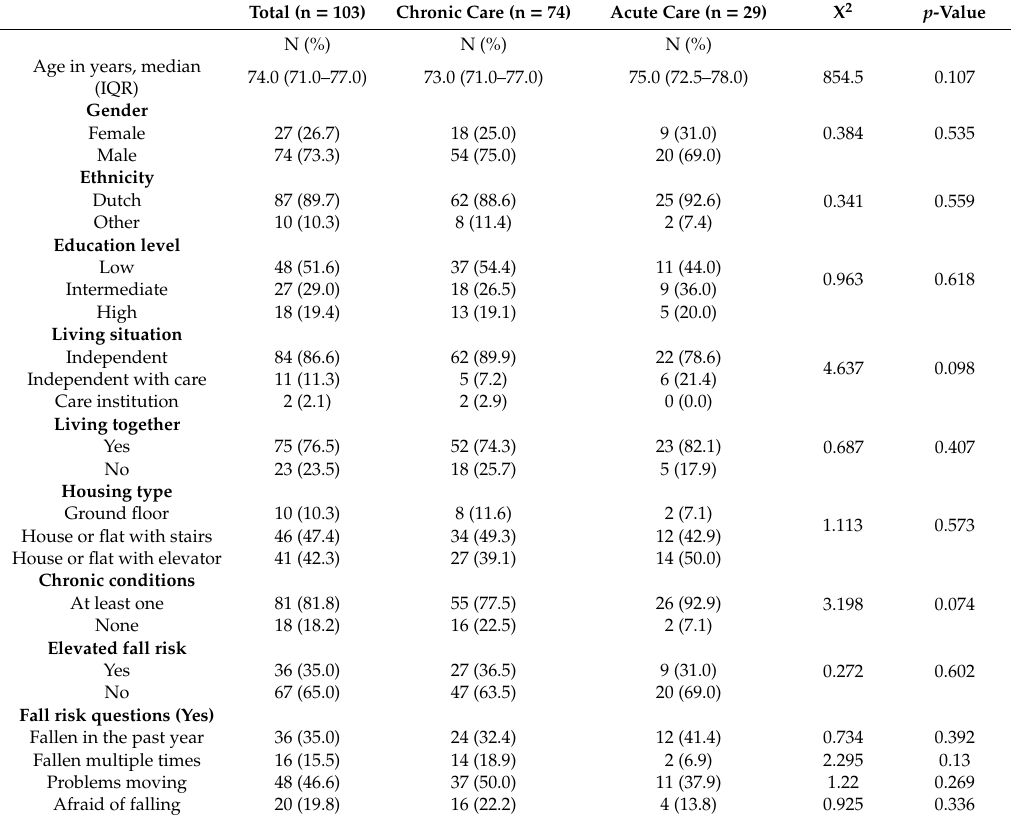
Table 1. Social demographics and risk of fall between acute-care and chronic-care